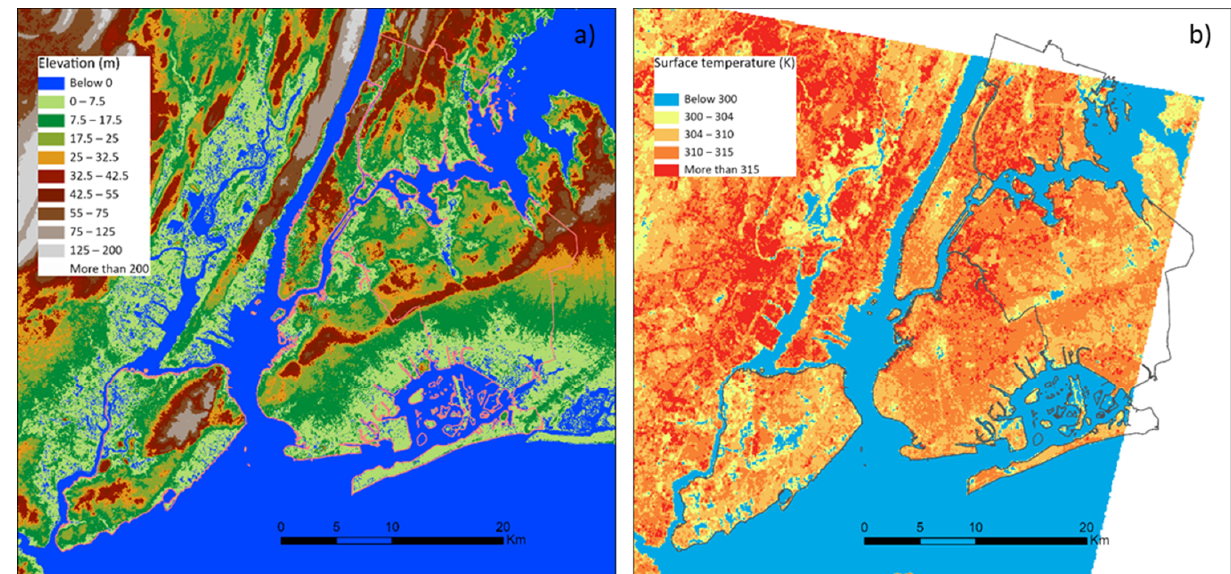
Figure 2. The maps showing: ( a ) The topography of New York City (at 30 m spatial resolution), ridges can be seen in the map, and ( b ) ASTER surface temperature (K) over New York City and surrounding locations on 8 September 2002.